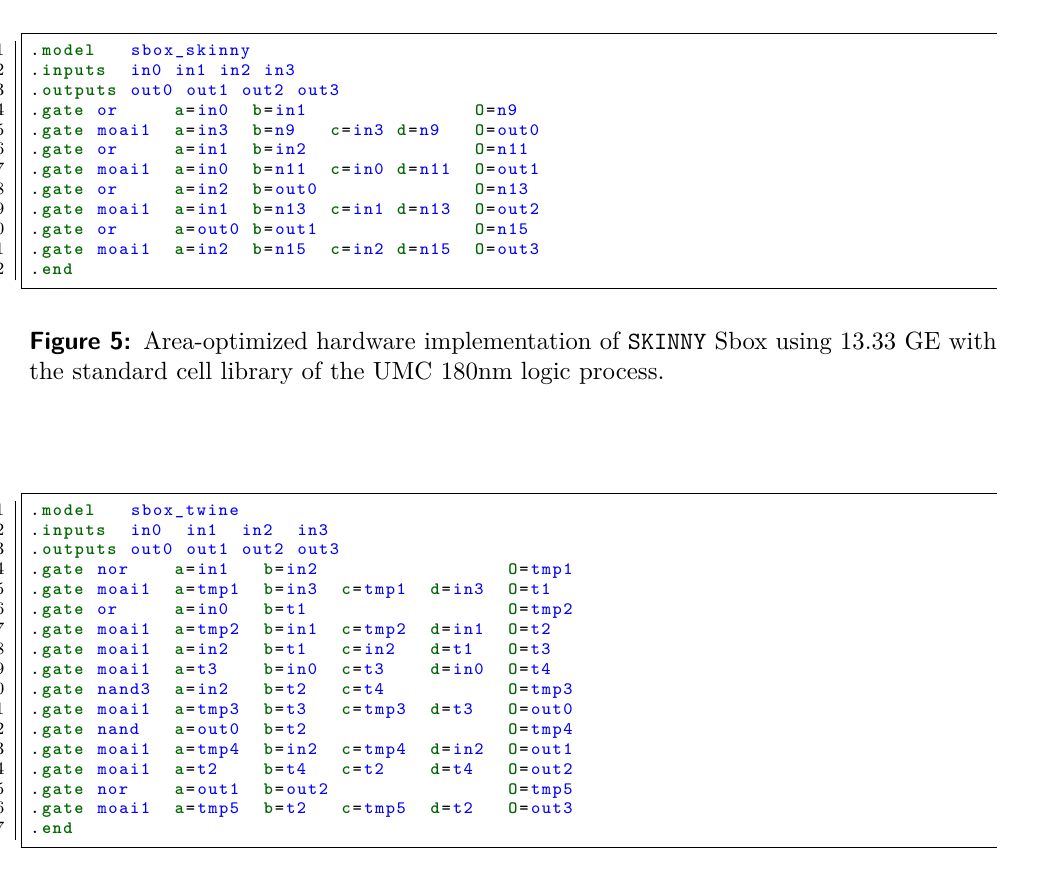
Figure 6: Area-optimized hardware implementation of TWINE Sbox using 21.67 GE with the standard cell library of the UMC 180nm logic process.